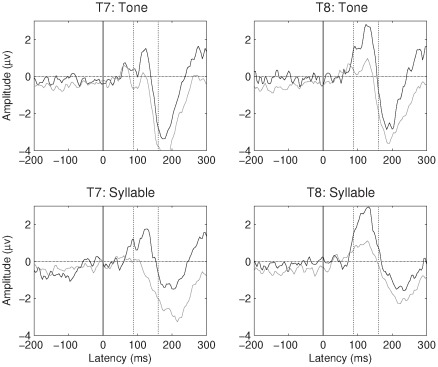
Average response at T7 and T8 for SLI (grey line) and TD (black line) children.